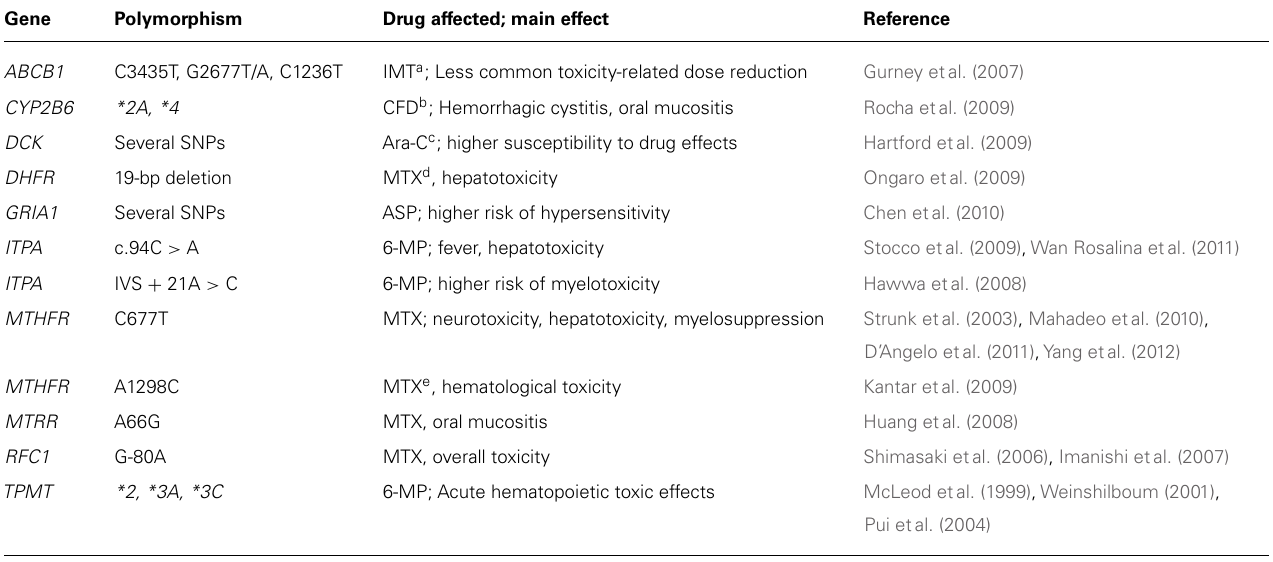
Table 1 | Summary of genes and polymorphisms with a putative relevant role in chemotherapy-induced toxicity in acute lymphoblastic